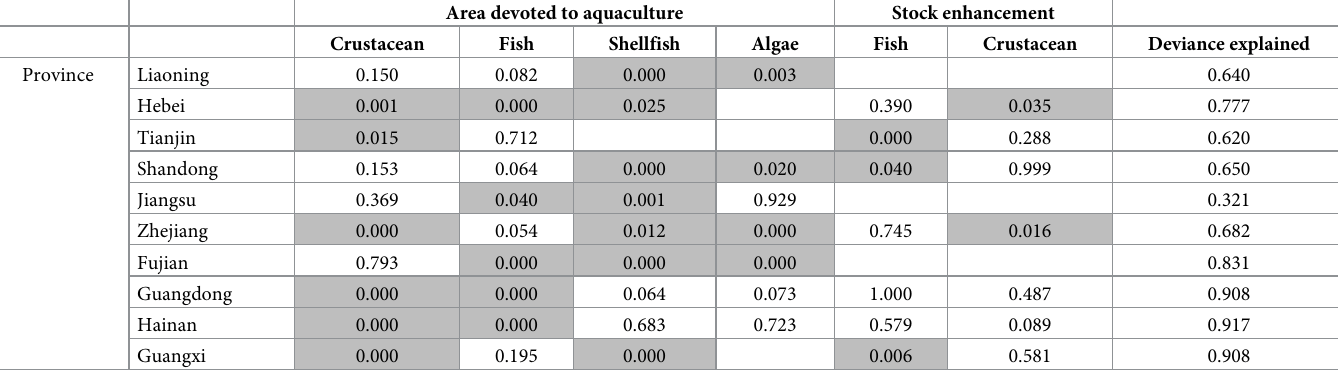
Table 2. Significance of the relationship between province level total CPUE and area devoted to aquaculture or stock enhancement identified by GAMs. P-values are reported here (p < = 0.05 shaded). See Fig 9 for the shapes of the estimated relationships. Deviance explained is in proportion and ranges from 0 to